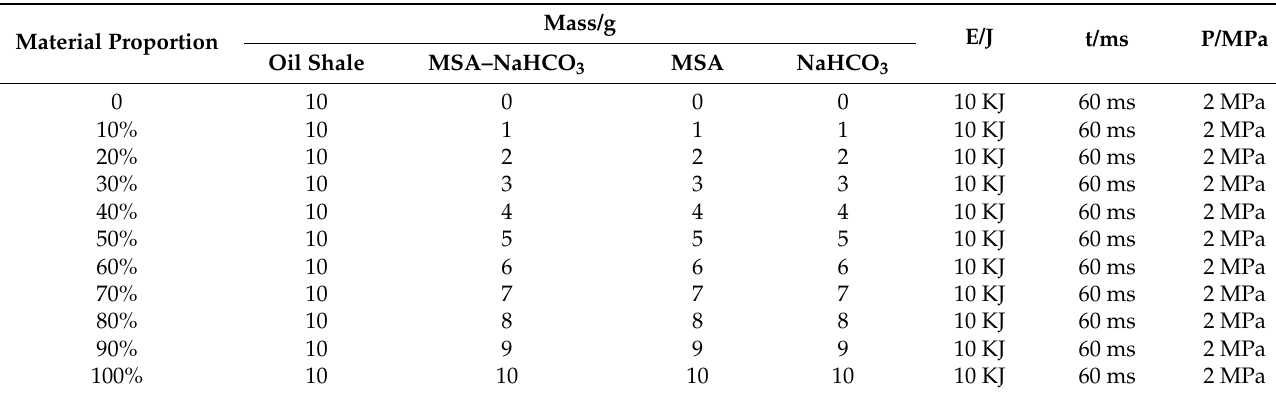
Figure 6. The 20 L spherical explosion system. Table 4. Material proportion of mixed